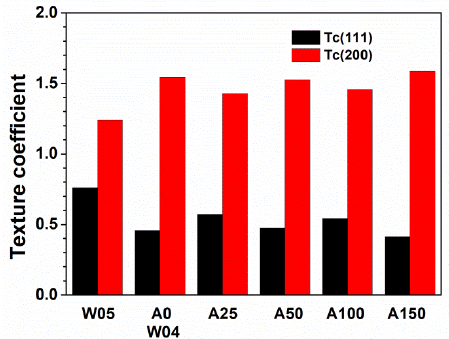
Figure 5. Texture coefficients of the W05 and Batch A samples.